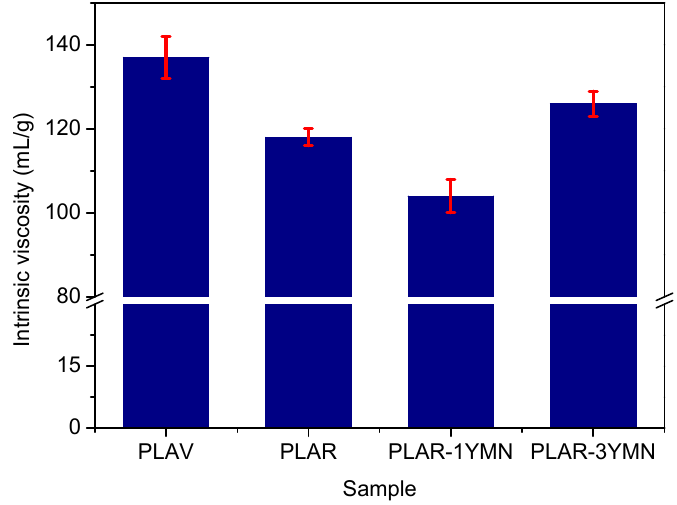
Figure 6. Intrinsic viscosity values of the different samples.